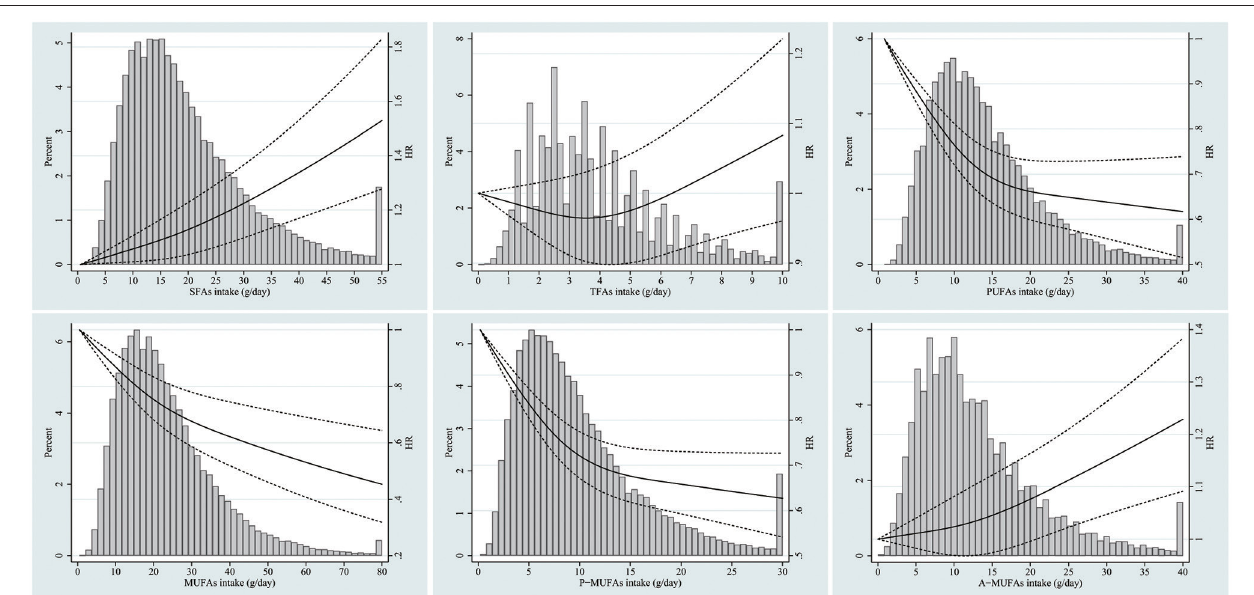
FIGURE 1 | Dose-response analyses for the association between intake of specific dietary fat and total mortality were performed using restricted cubic spline model. Solid lines represent point estimates and dashed lines represent 95% confidence intervals (CIs). Multivariable Hazard ratios (HRs) were calculated by restricted cubic spline regression (using three knots at 10th, 50th, and 90th percentiles) adjusting for age, gender, race, body mass index, education, smoking status, total energy intake, alcohol drinking status, study center, marital status, randomization arm, aspirin use, history of hypertension, history of diabetes, history of stroke, history of heart attack, vegetables intake, fruit intake, and other remaining fatty acids. The histograms show the percentage of participants (left y axis) belonging to each level of specific dietary